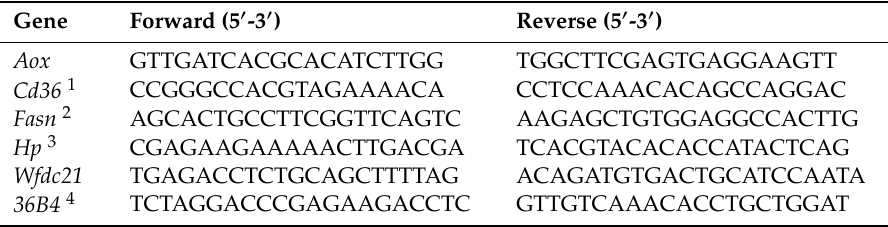
Table 2. PCR primer sequences used in gene expression